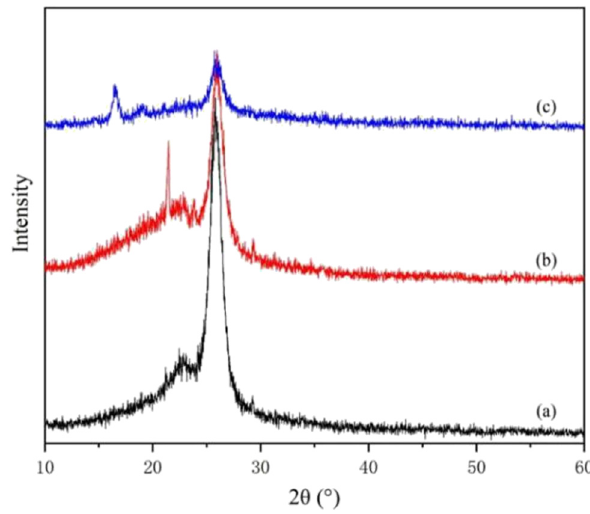
Figure 9: XRD patterns of ( a ) U - BF, ( b ) C - BF, and ( c ) K1.0 - BF.